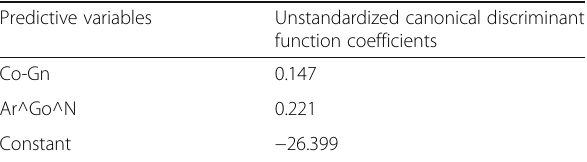
Table 5 Discriminant function Predictive